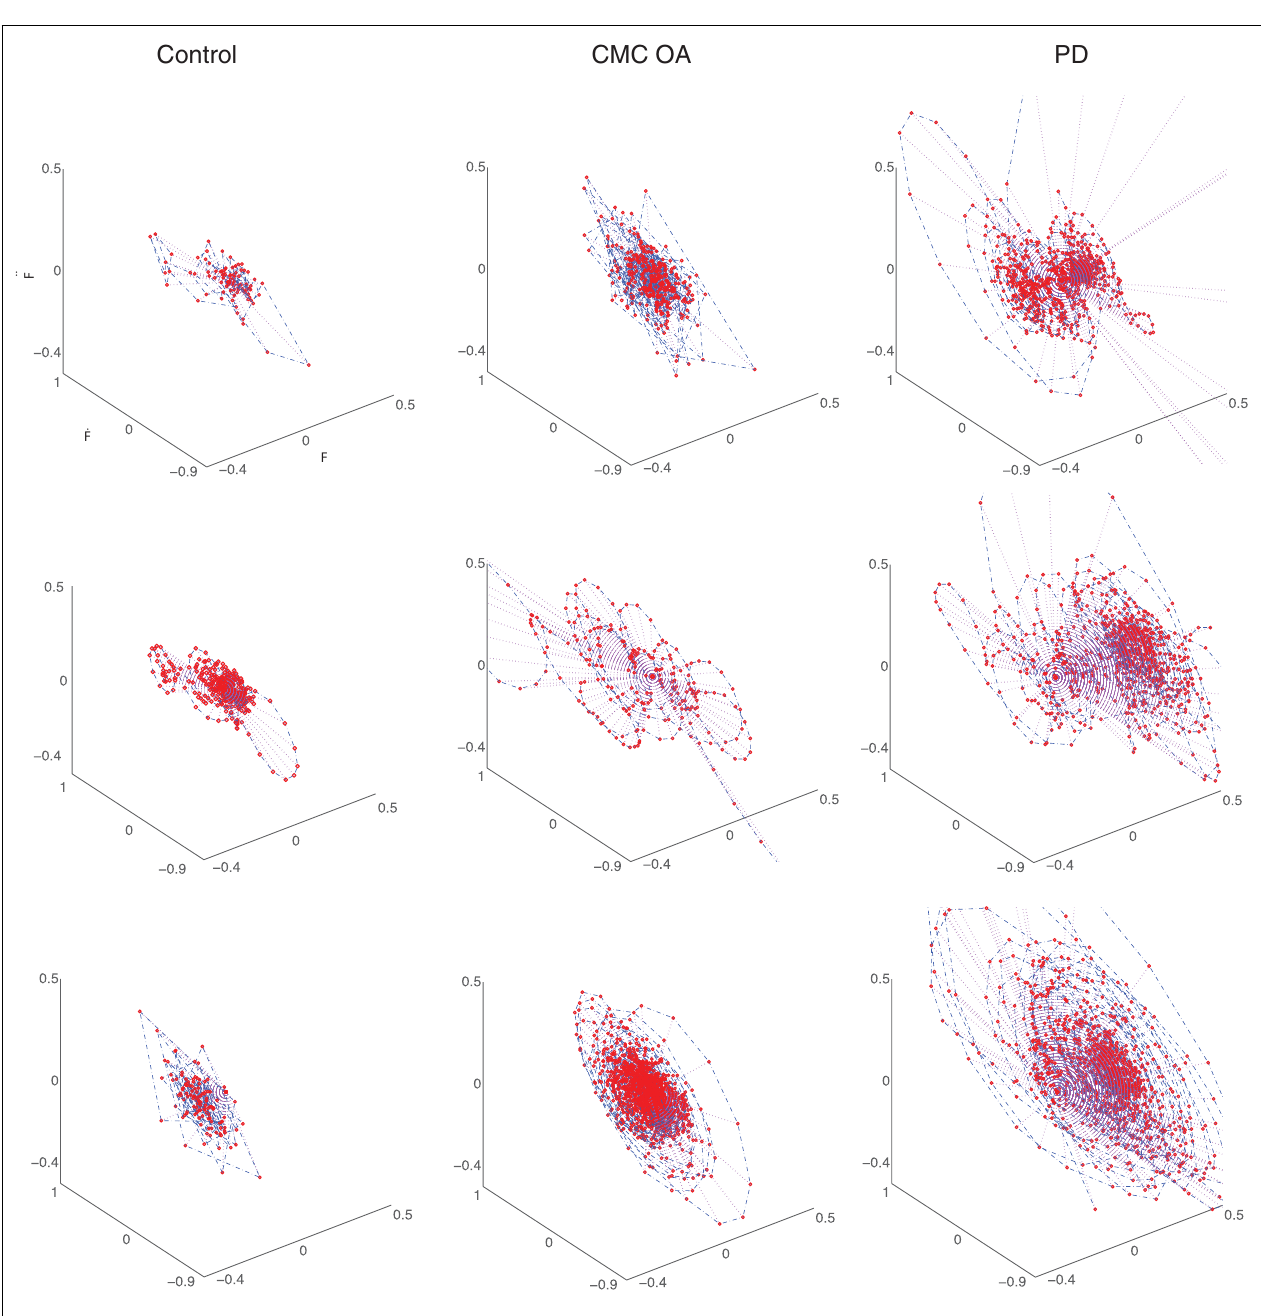
FIGURE 5 | Representative phase portraits of three participants from each group (ages between 70 and 75years): healthy control subjects (first column), participants diagnosed with CMC OA (second column),